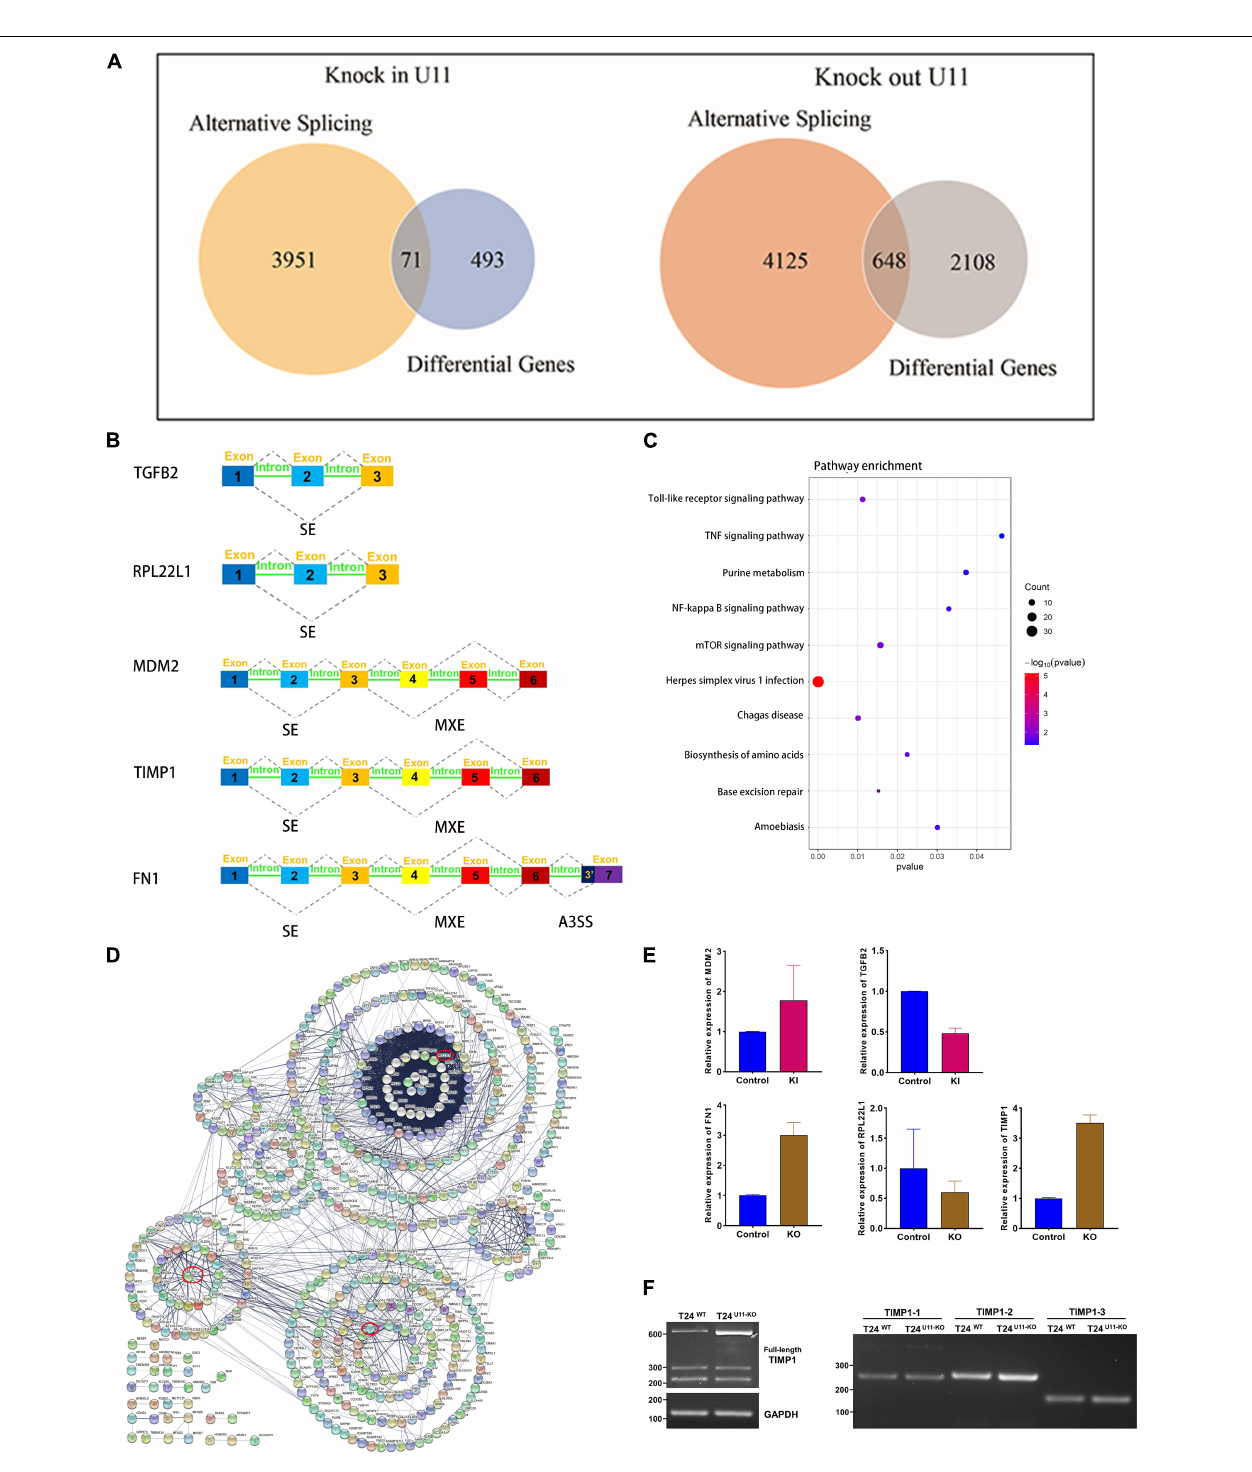
FIGURE 6 | Comprehensive analysis of alternative splicing events and differential genes upon knocking out and overexpressing U11 in T24 cell lines. (A) Venn diagrams of DEGs and genes with significant alternative splicing events. (B) Diagrams of alternative splicing events in MDM2, TGFB2, RPL22L1, FN1, and TIMP1. Mutually exclusive exons (MXE) and skipped exon (SE) in MDM2; SE in TGFB2; SE in RPL22L1; MXE and SE in TIMP1; MXE, SE and alternative 3 (cid:48) splice site (A3SS) in FN1. (C) Pathways from intersecting genes between T24 U11 − KO and T24 WT cell lines. (D) Venn diagram of Protein–protein interactions (PPI) of intersecting genes. (E) The relative expression levels of MDM2 and TGFB2 between T24 U11 − KI and T24 WT cell lines and the relative expression levels of FN1, RPL22L1, and TIMP1 between T24 U11 − KO and T24 WT cell lines. (F) Alternative splice identification of TIMP1-full length, TIMP1-1, TIMP1-2, and TIMP1-3 in T24 U11 − KO and T24 WT cell